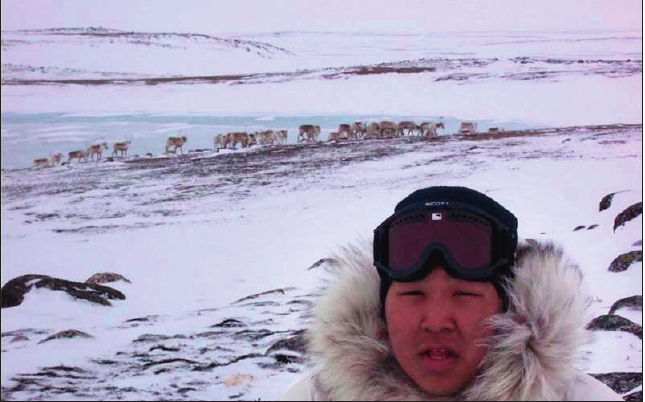
Fig. 1. The author’s son and caribou herd outside of Rankin Inlet. Credit: Gabriel